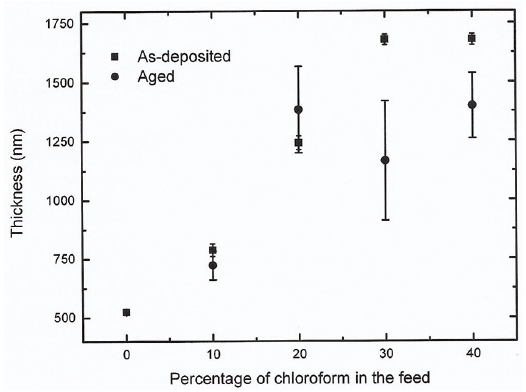
Figure 1: Film thickness as a function of C and aged films.